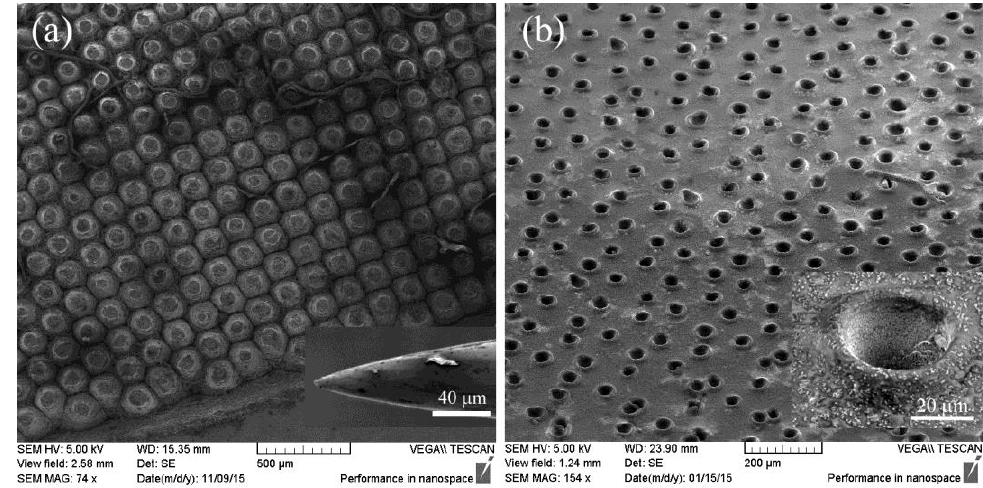
Figure 3. SEM images of ( a ) the top view of the homemade metallic mold (with the inset showing the needle tip used in the mold) and ( b ) the deformed COP–TiO 2 layer obtained by using a hot embossing process (with the inset showing an enlarged image of the hole with an inverted cone shape).